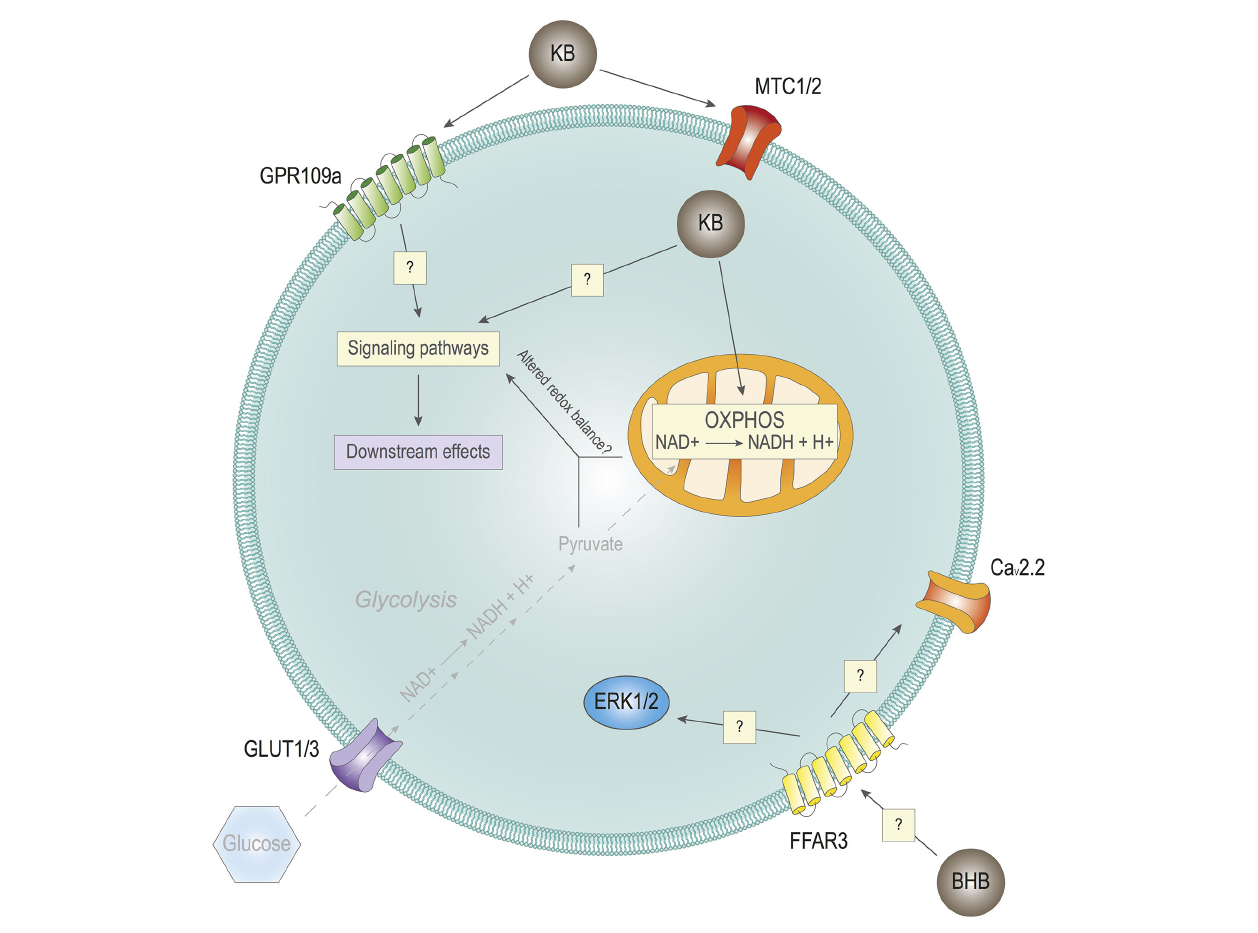
FIGURE 3 | Effects of ketone bodies on cell signaling. Hypothetical impact of Ketone bodies (KB) on cell signaling. KB may impact cell signaling through their extracellular receptors GPR109a and/or FFAR3, having an impact on intracellular cell signaling. KB may also impact cell signaling by entering cells through the monocarboxylate transporters (MTCs) 1/2. Inside the cell, in combination with reduced or absent glycolysis due to very low levels of glucose, KB may alter the redox balance of the cell, also with potential consequences in cell signaling. In turn, the alterations in the signaling pathways of the cell lead to different downstream effects with biological